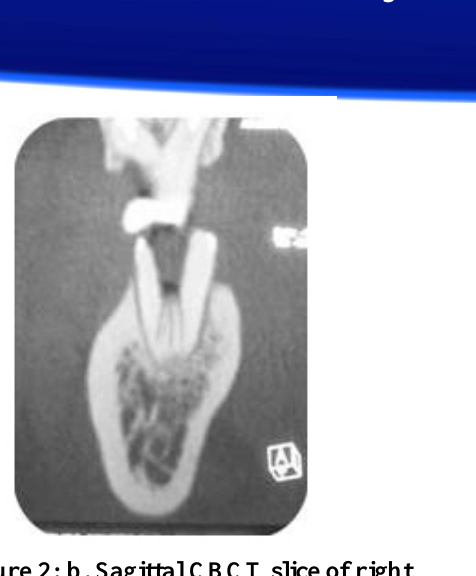
Figure 2: b. Sagittal CBCT slice of right mandibular first molar